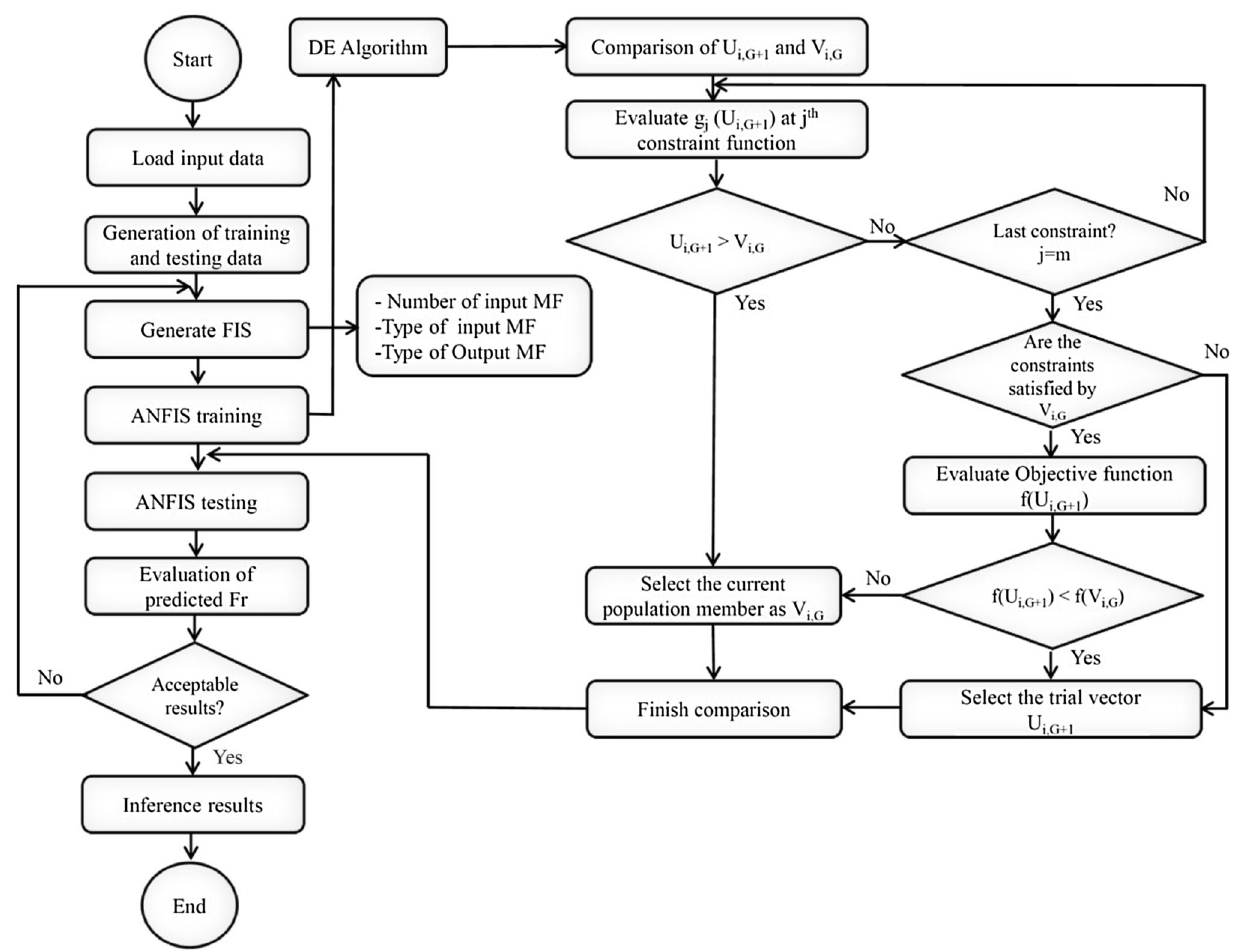
Fig. 3 Flowchart of proposed method